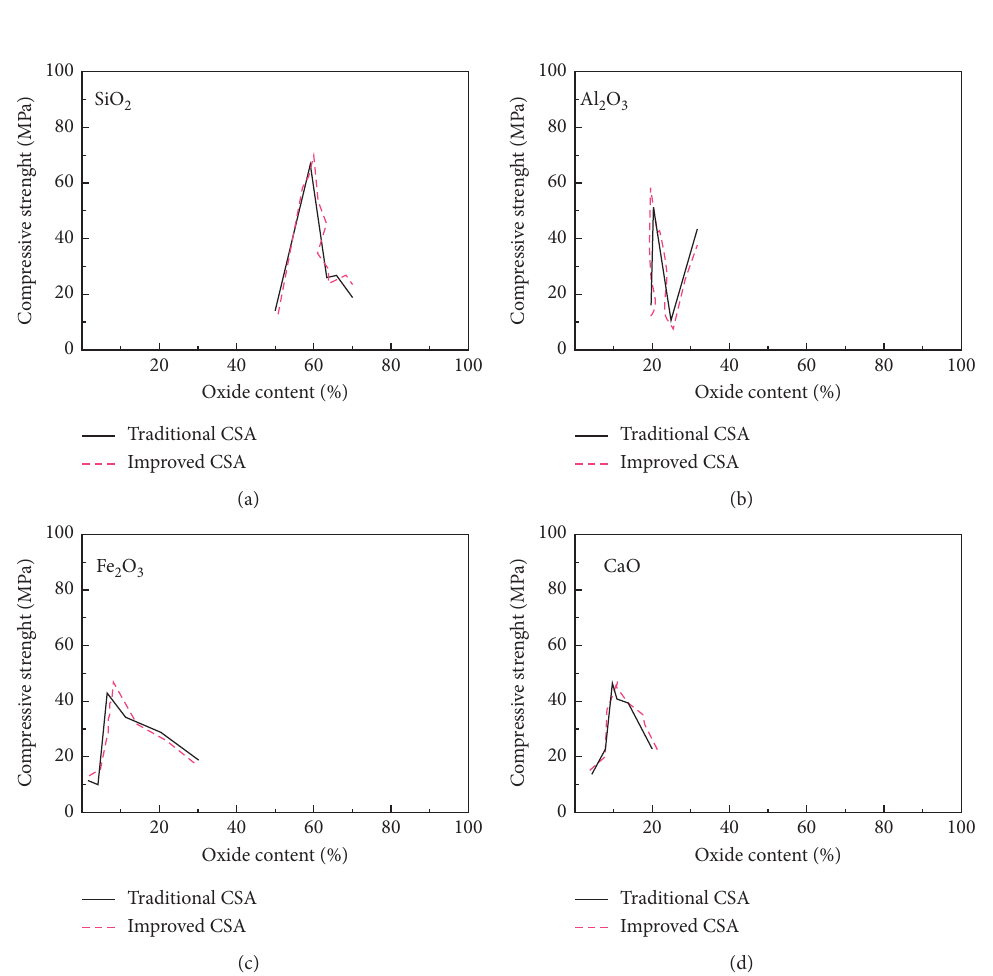
Figure 3: Variation of 7d compressive strength with different oxide proportion. (a) Compressive strength vs. SiO vs. Al 2 O 3 . (c) Compressive strength vs. Fe 2 O 3 . (d) Compressive strength vs. CaO.